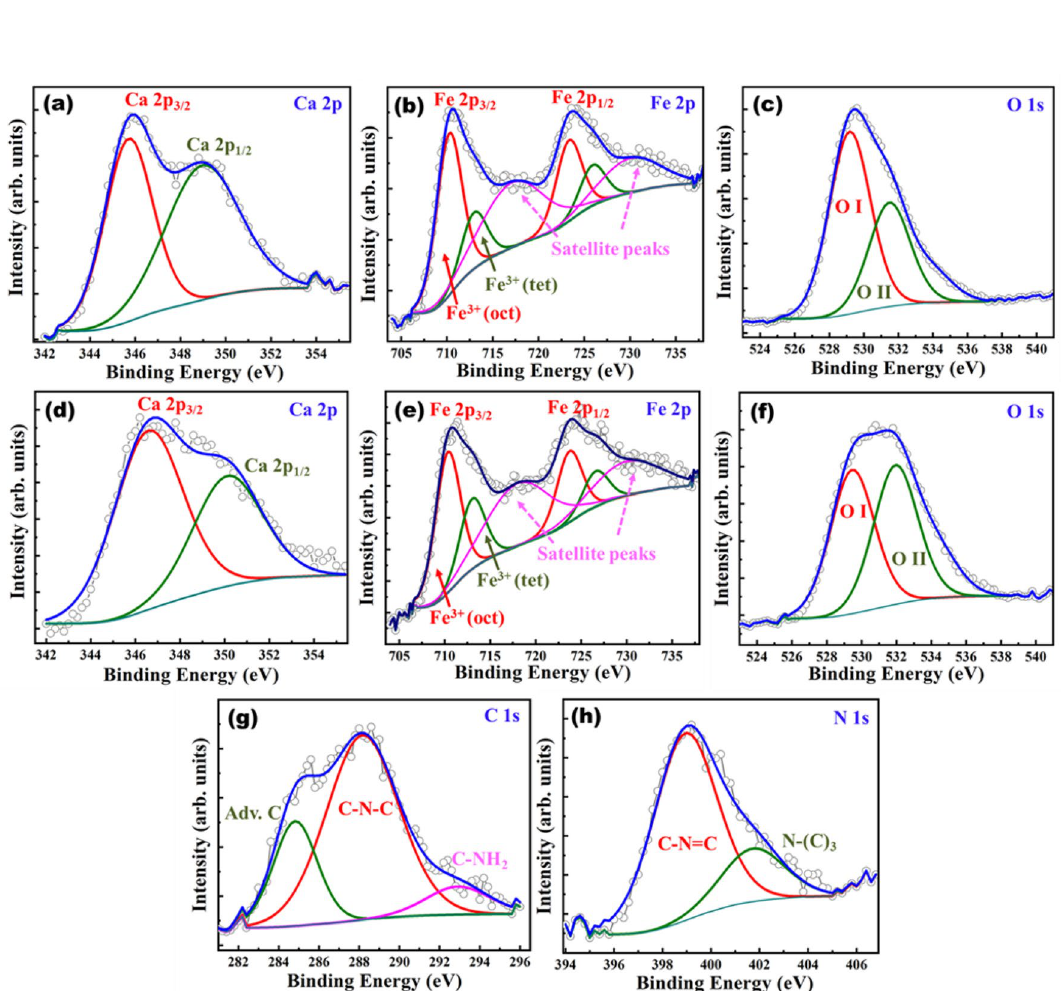
Figure 3. X-ray photoelectron spectra (de-convoluted) and the corresponding fits corresponding to CFO and CCN50 samples: in CFO ( a ) Ca 2p, ( b ) Fe 2p ( c ) O 1 s and, in CCN50 ( d ) Ca 2p, ( e ) Fe 2p, ( f ) O 1 s, ( g ) C 1 s, ( h ) N 1